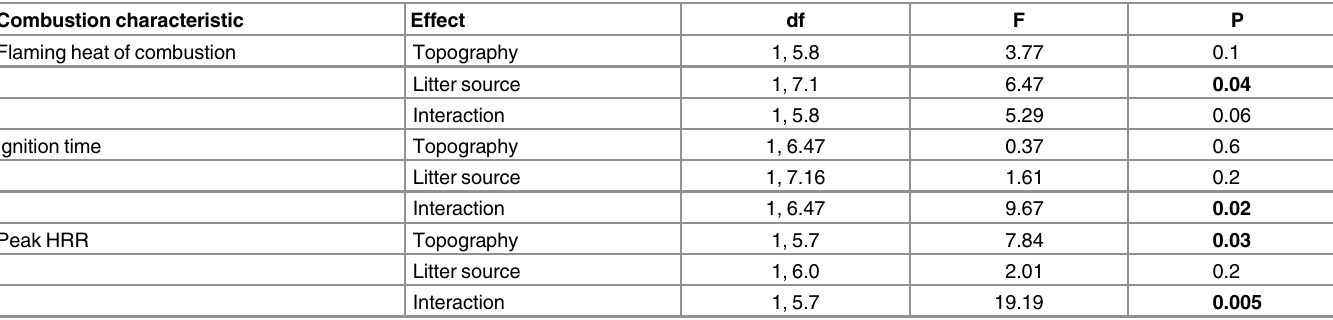
Table 5. The effects of litter source and topographic position on fuel combustion characteristics (see also Fig 9). Combustion